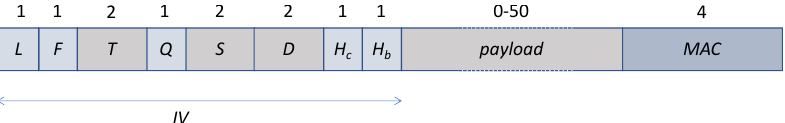
Figure 6. Packet format for secure